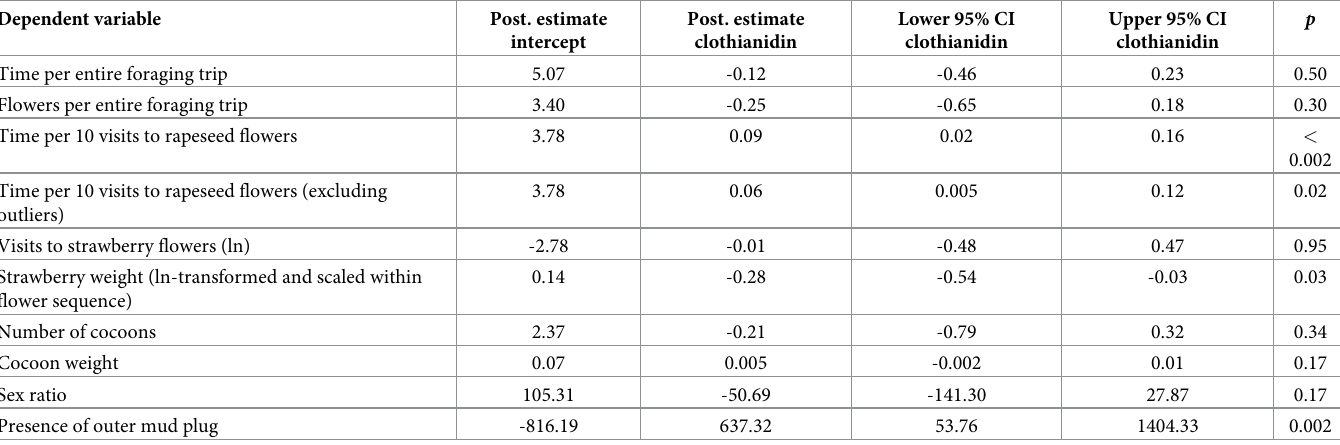
Table 4. Summary of the results from statistical analyses.